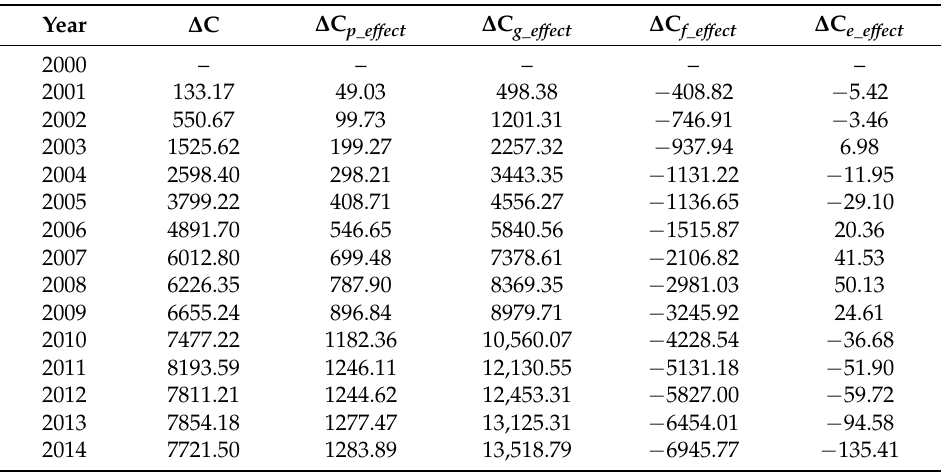
Table 1. Results of the Logarithmic Mean Divisia Index (LMDI) Decomposition. Year ∆ C ∆ C